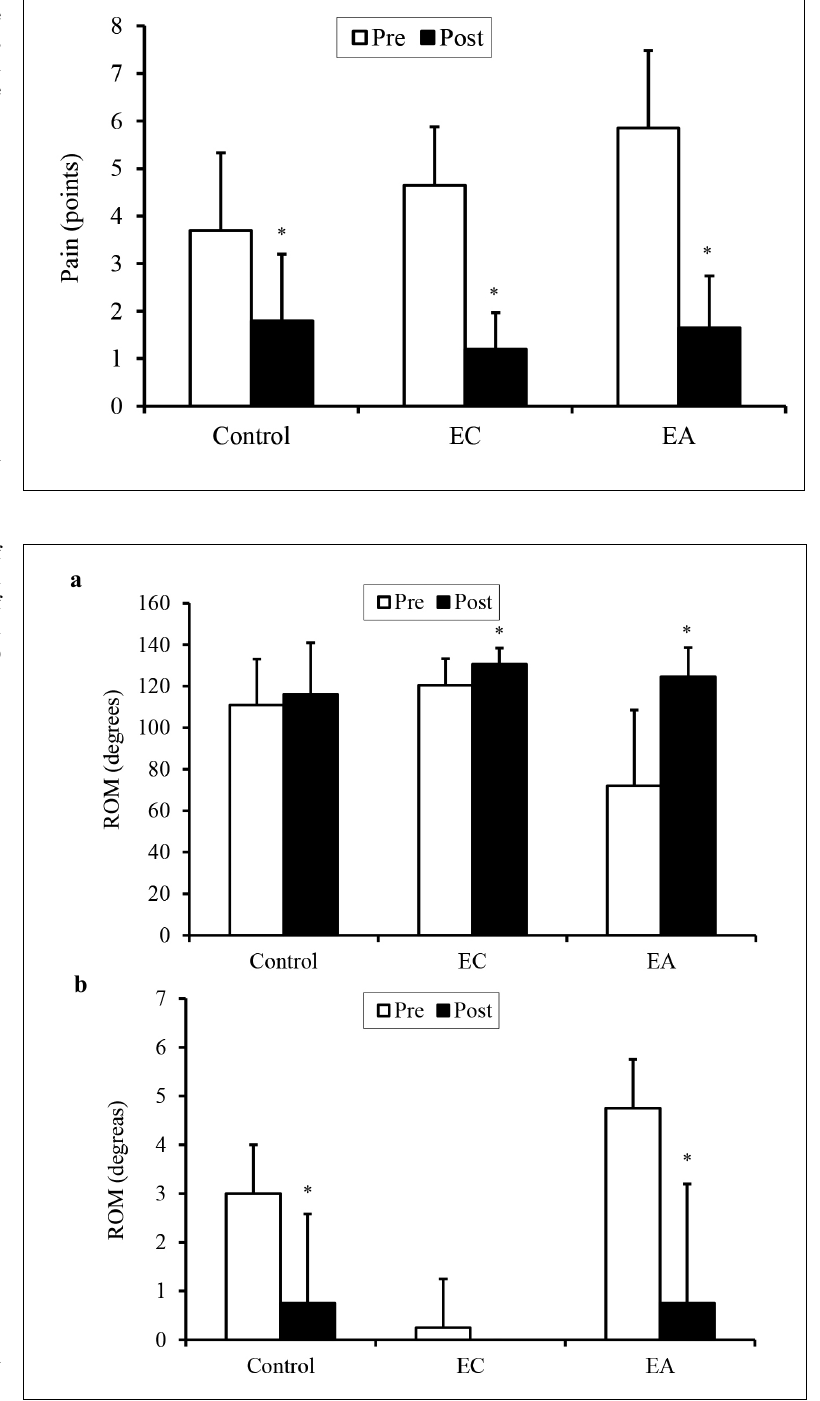
Note . * p < .05 comparing to pre intervention